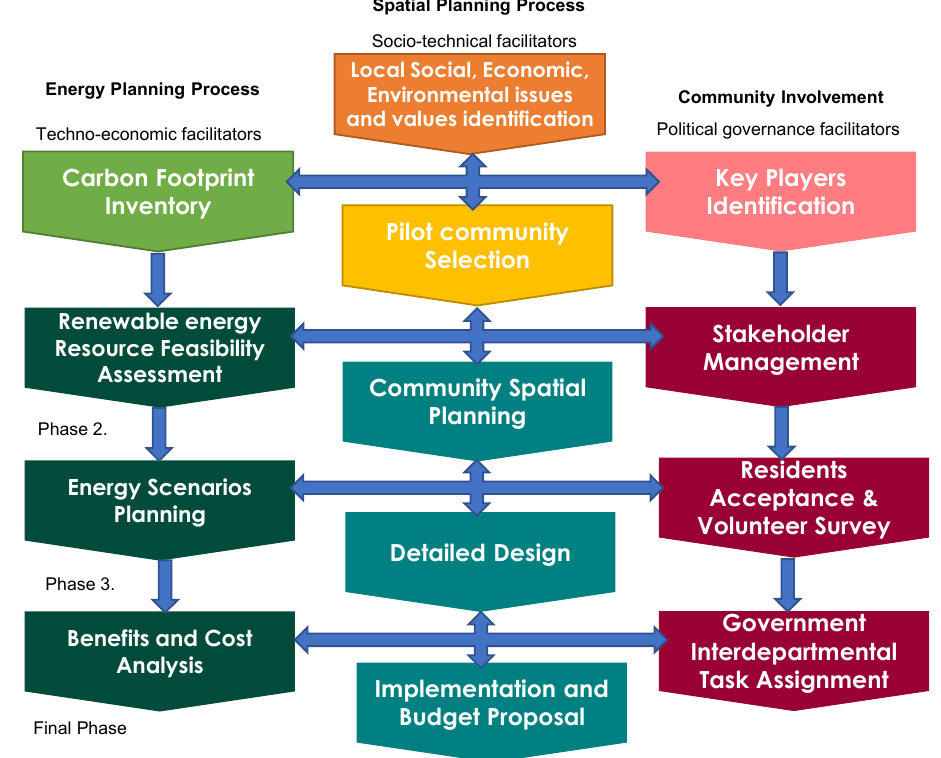
Figure 2. The task framework of Pinglin LCC Planning and Design Project. Table 1. LCC’s data use inventory for each phase of energy planning, spatial planning